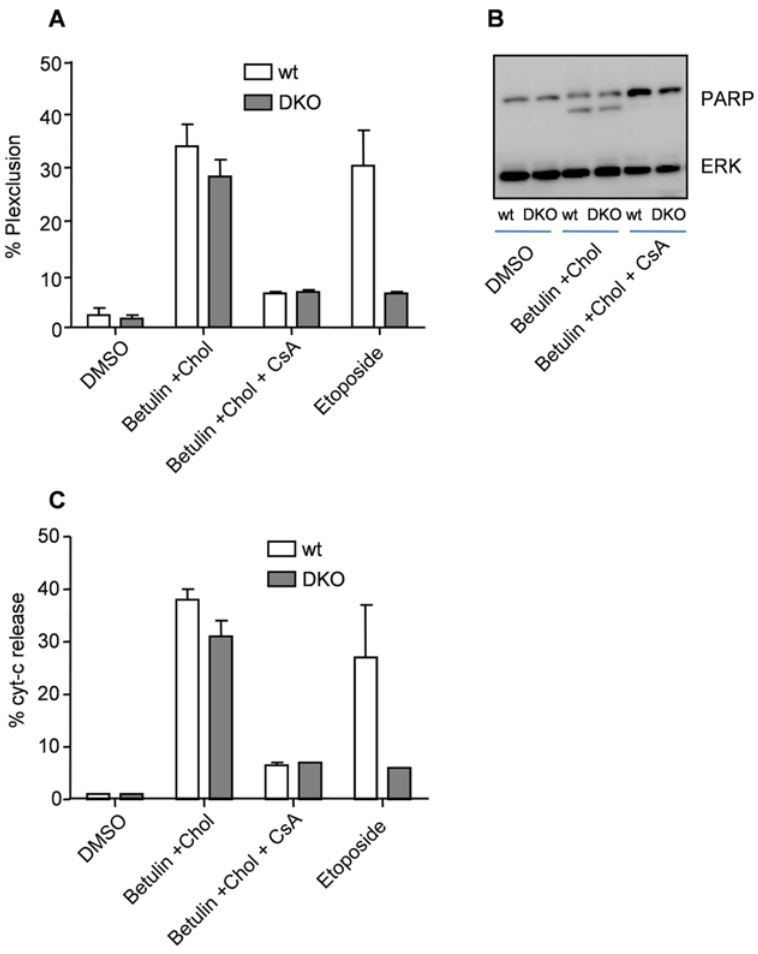
Figure 5. BE/cholesterol induced apoptosis is independent of Bax/Bak. (A) Wildtype (wt) or Bax/Bak double knockout (DKO) mouse embryonic fibroblasts (MEFs) were treated as indicated and after 24 hours cell death was assessed by PI exclusion. Etoposide was included as a control for functionality of the cells. (B) Wt or DKO MEFs were treated as indicated and after 24 hours cells were subjected to immunoblotting to determine PARP processing. ERK was used as control for equal protein amounts. (C) Wt and DKO MEFs were treated as indicated for 24 hours before measuring cytochrome c release by intracellular FACS staining.